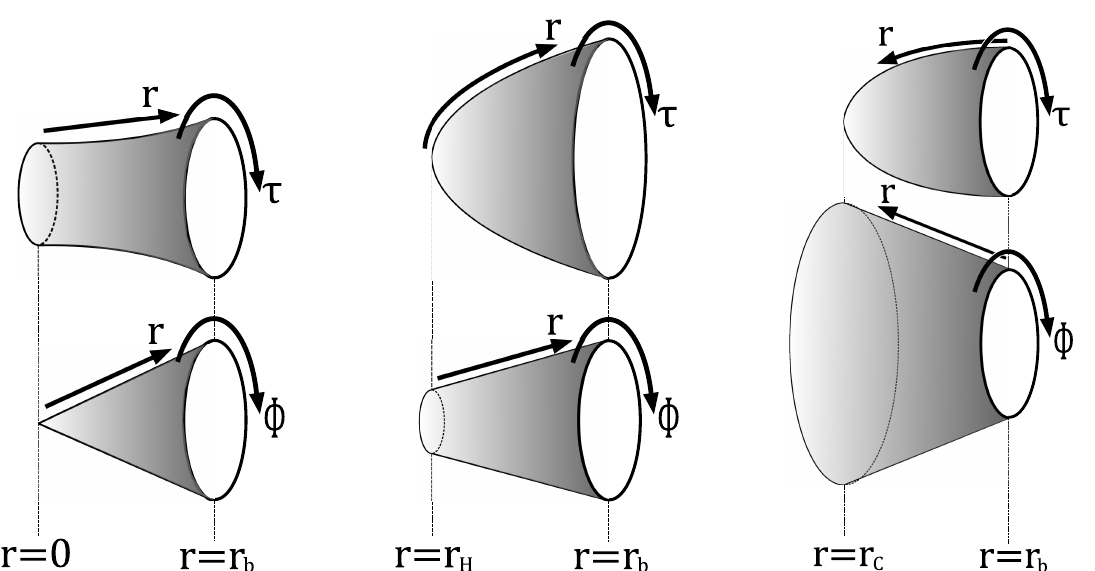
Figure 8 . Types of saddle point. Their geometries are qualitatively similar to those of the pure gravity case. The gradation schematically represents the value of the scalar field. ( Left ) Euclidean soliton ( B 3 × S 1 topology). ( Middle ) Euclidean BH ( S 2 × D topology). ( Right ) BG instanton ( S 2 × D topology). Figure 9 . Three types of PL geometry whose S 2 radius grows from the boundary, reaches some maximum radius r , and shrinks toward the center or the bolt. The gradation schematically max represents the value of the scalar field. ( Left ) Euclidean PL-soliton ( B 3 × S 1 topology). ( Middle ) Euclidean PL-BH ( S 2 × D topology). ( Right ) PL-BG instanton ( S 2 × D